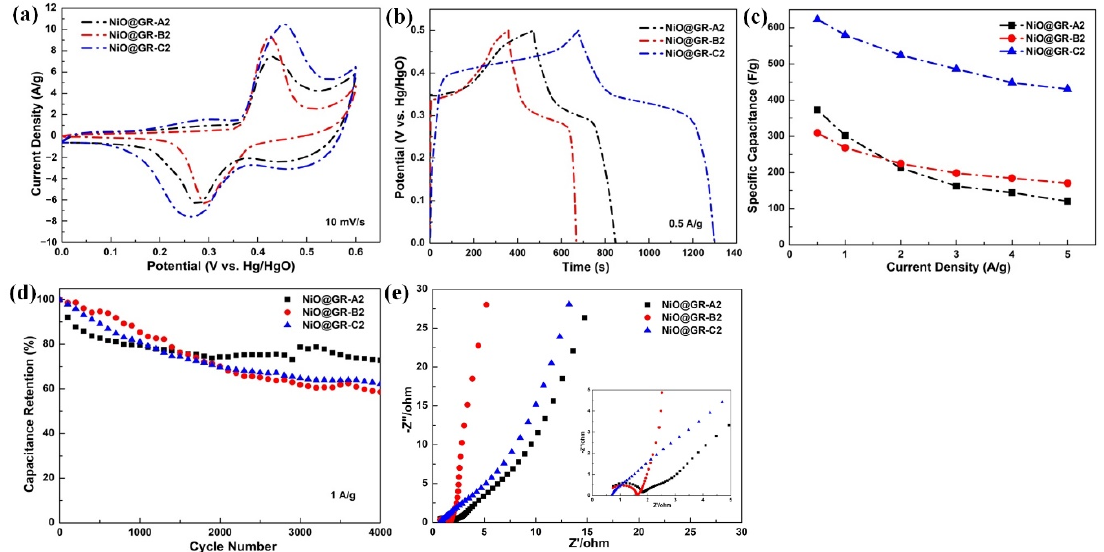
Figure 4. ( a ) CV and ( b ) GCD curves of NiO x @GR-A2, NiO x @GR-B2, and NiO x @GR-C2. ( c ) Specific capacitance of the NiO x @GR-A2, NiO x @GR-B2, and NiO x @GR-C2 nanocomposites at different current densities. ( d ) Cyclic stability of NiO x @GR-A2, NiO x @GR-B2, and NiO x @GR-C2. ( e ) Nyquist plots of the EIS for the NiO x @GR-A2, NiO x @GR-B2, and NiO x @GR-C2 electrodes. The inset shows the enlarged EIS of the electrodes.